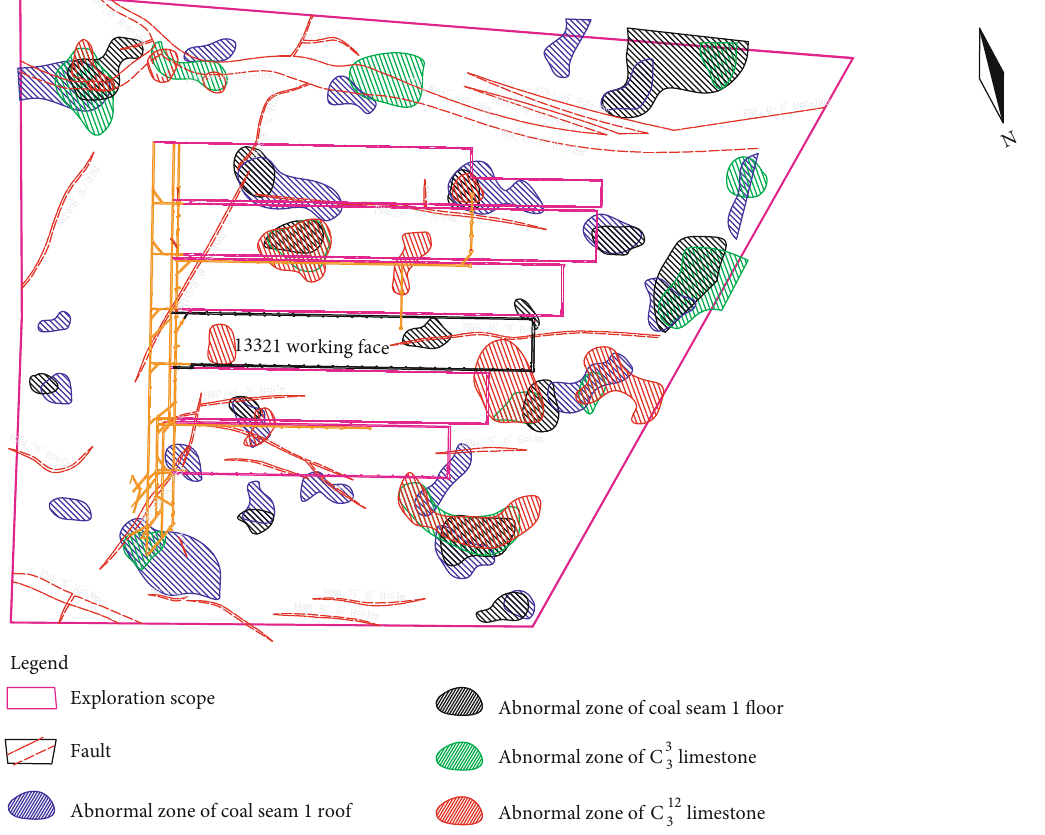
Figure 3: Water-abundance zone distribution of the South No.1 mining area, 13321 working face exists in two abnormal water-abundance zones of C 312 limestone and two sandstone fi ssure water-abundance